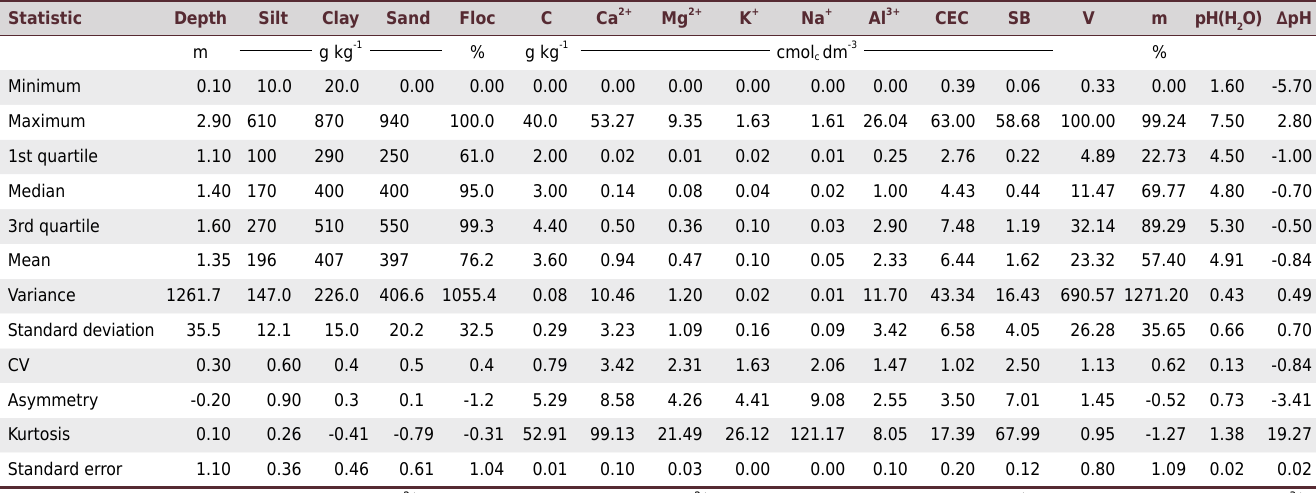
Table 1. Descriptive statistics considering all profiles of Ultisols (Bt horizon) described by survey of RADAMBrazil. Statistic Depth Silt Clay Sand Minimum Maximum Median 1.40 170 Mean Variance 1261.7 Standard deviation 35.5 Asymmetry -0.20